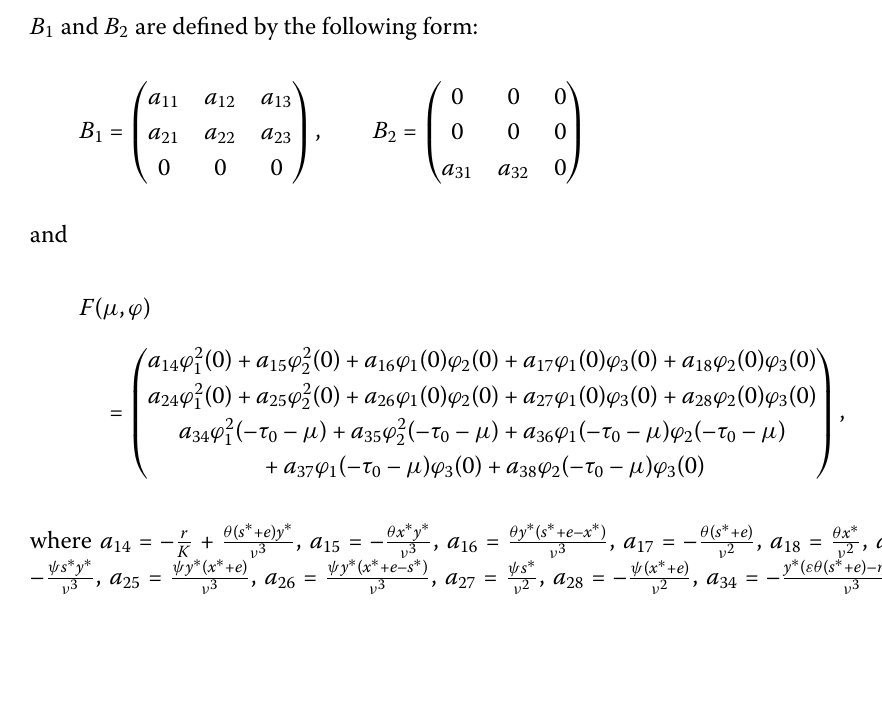
γ – i plane, respectively. The parameters are chosen from [5] as r = 0.1, θ = 5, e = 1, ψ = 5, (cid:17) = 0.1, η = 0.1, δ = 0.1. In the left figure we use γ = 1 and in the right K = 0.2.